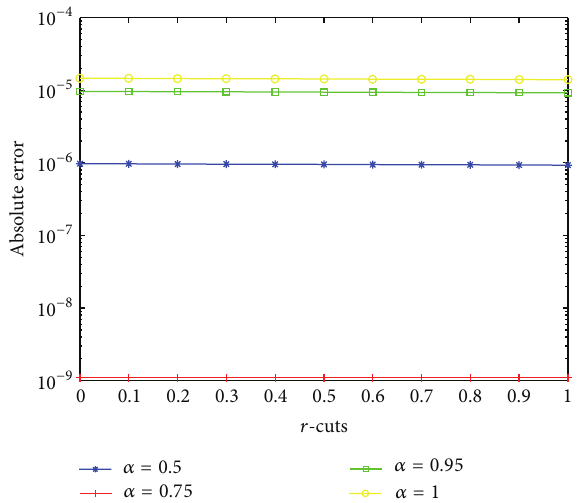
Figure 6: The absolute error for different values 𝛼 with V = 0.75 , = 0.012 , 𝑚 = 7 , and 𝑘 𝑘 1